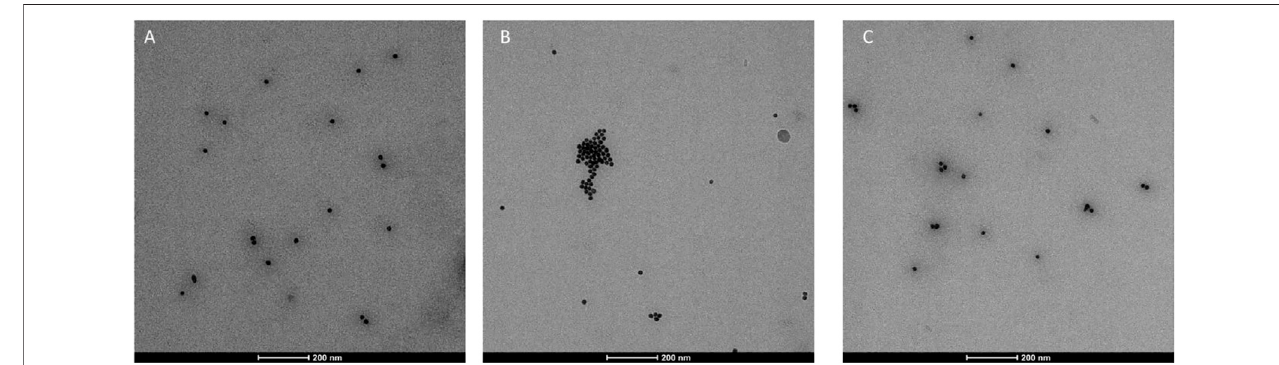
( Figure 5A ), while in the case of 7 + 10 @AuNPs the presence of aggregates was observed, con fi rming the UV-Vis and DLS